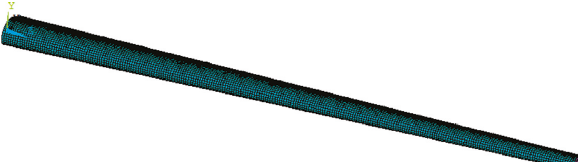
Figure 5: FE model in ANSYS of the tapered wind turbine blade.